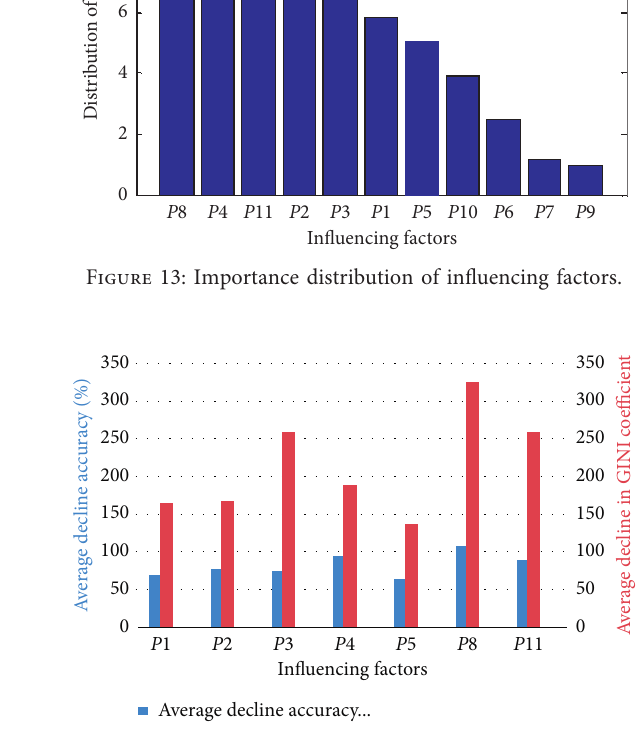
Figure 14: Average decline accuracy and average decline Gini coefficient.